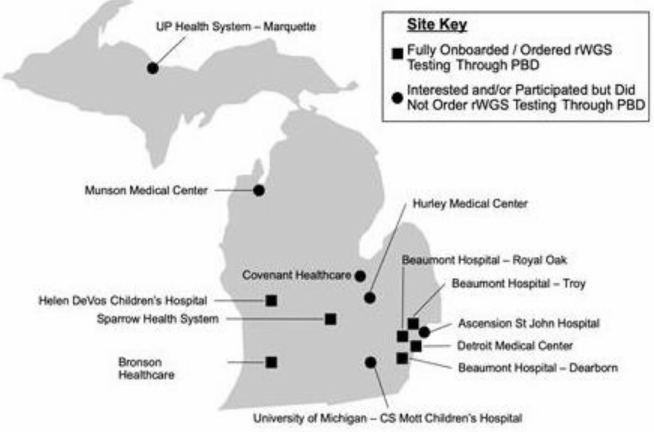
Figure 2. Map of Michigan Project and Baby Deer Hospital